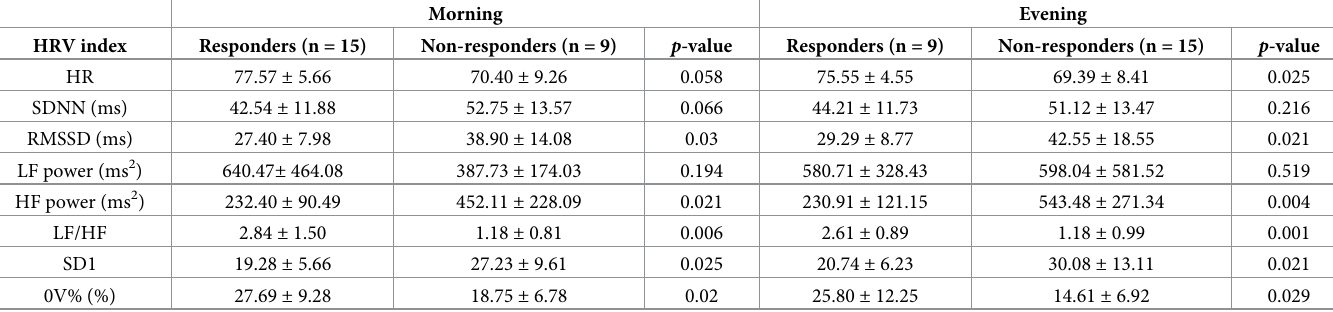
Table 4. HRV baseline measurements and the statistical significance in responders and